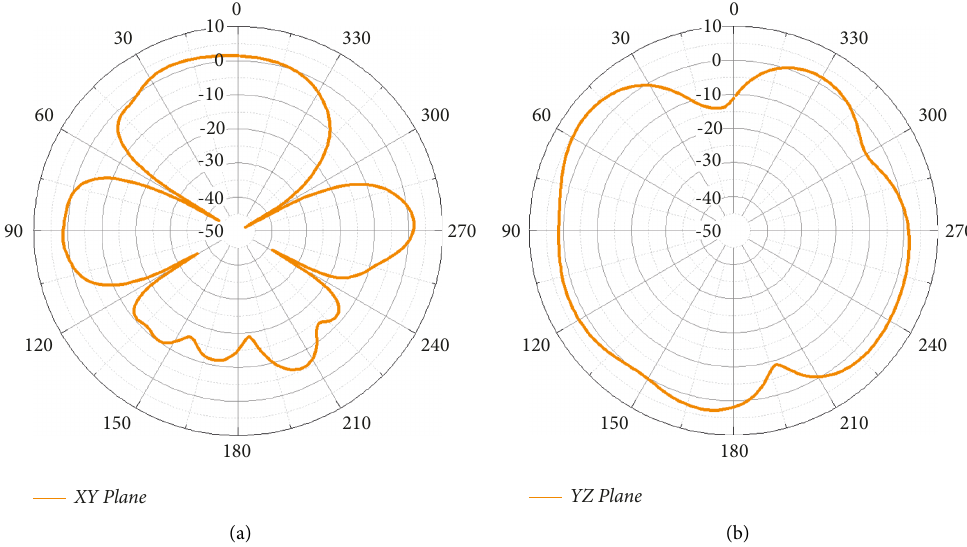
Figure 22: 2D radiation patterns (1 × 4 array) on (a) XY plane and (b) YZ plane.